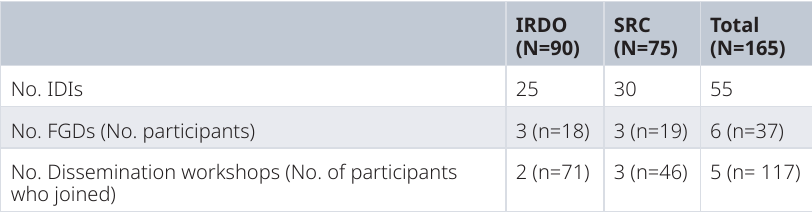
Table 2. Qualitative activities by site and overall for the TRIO qualitative